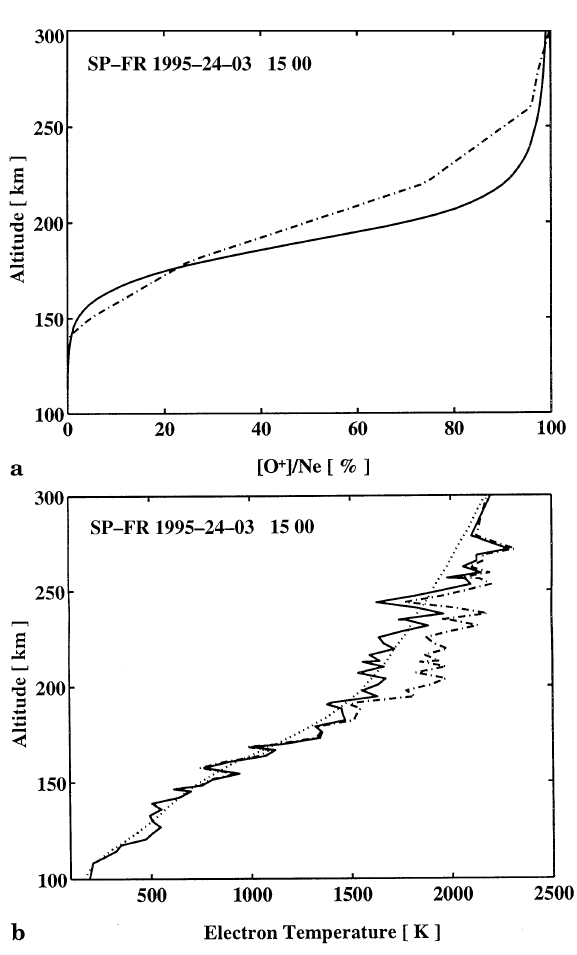
Fig. 2a,b. Vertical profiles at 1500 UT, between 100 and 300 km, of a [O (cid:96) ]: N (cid:101) parameter for standard statistical model ( dot - dashed line ) and the result of the simulation ( full line ); b electron temper- ature calculated by the standard analysis ( dot - dashed line ), corrected electron temperature ( full line ) and electron temperature resulting from the simulation ( dotted line